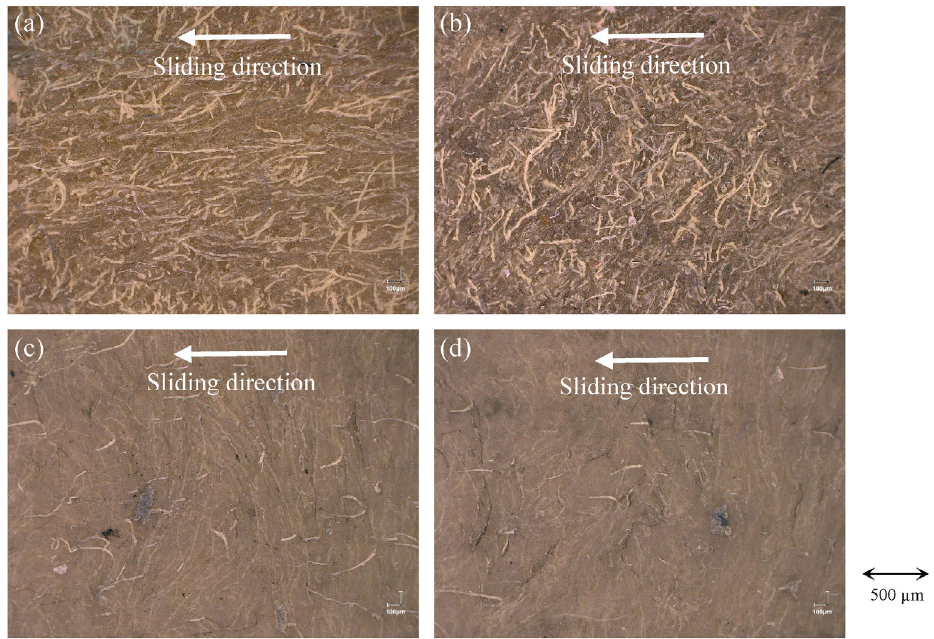
Fig. 6 Wear surfaces after tribometer tests: (a) composite 15 SF at a contact pressure of 0.2 MPa, (b) composite 15 EF at a contact pressure of 0.2 MPa, (c) composite 20 SF+silica at a contact pressure of 0.68 MPa, and (d) composite 20 EF+silica at a contact pressure of 0.68 MPa.